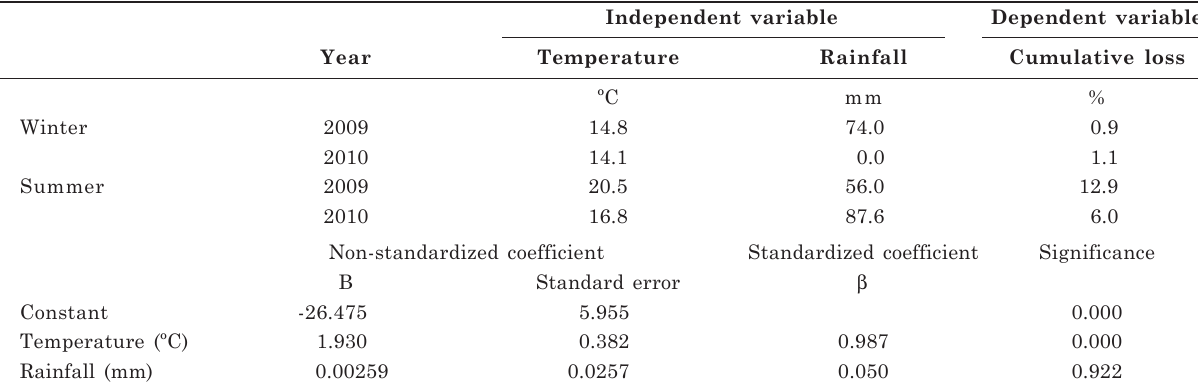
Table 4. Mean air temperature and cumulative rainfall in the five days after fertilization (independent variables) and cumulative volatilization losses of ammonia from urea (dependent variable) in the winter (wheat) and in the summer (maize) in two growing seasons (2009 and 2010), and the respective coefficients of the linear multiple regression